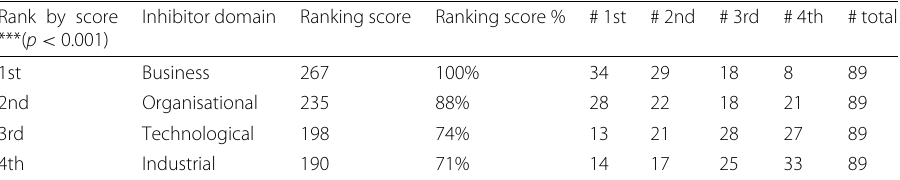
Table 14 Ranking of inhibitor domains ( N = 89) Rank by score ***( p <